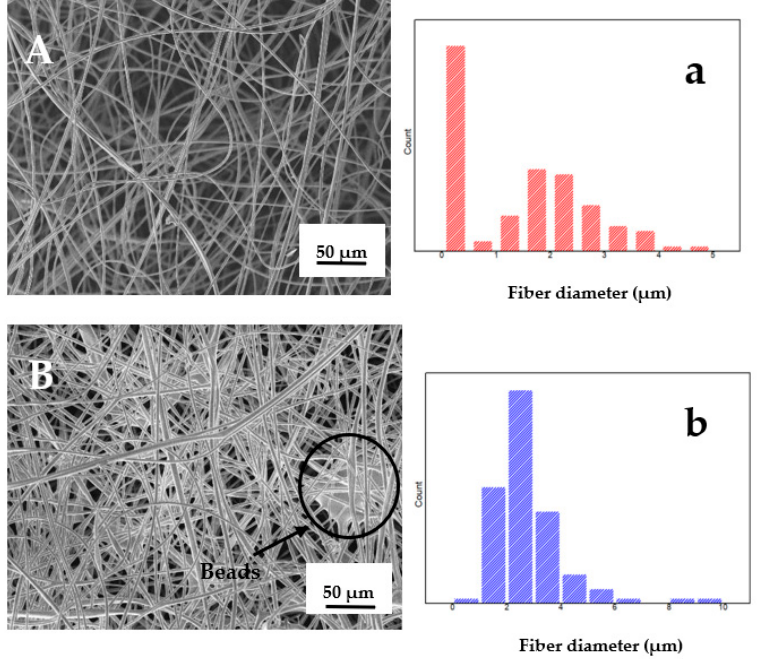
Figure 4. SEM micrographs of pads fibers and histograms showing the fiber diameter distribution: pad F 0 ( A ) and ( a ); pad F 1 ( B ) and ( b ).